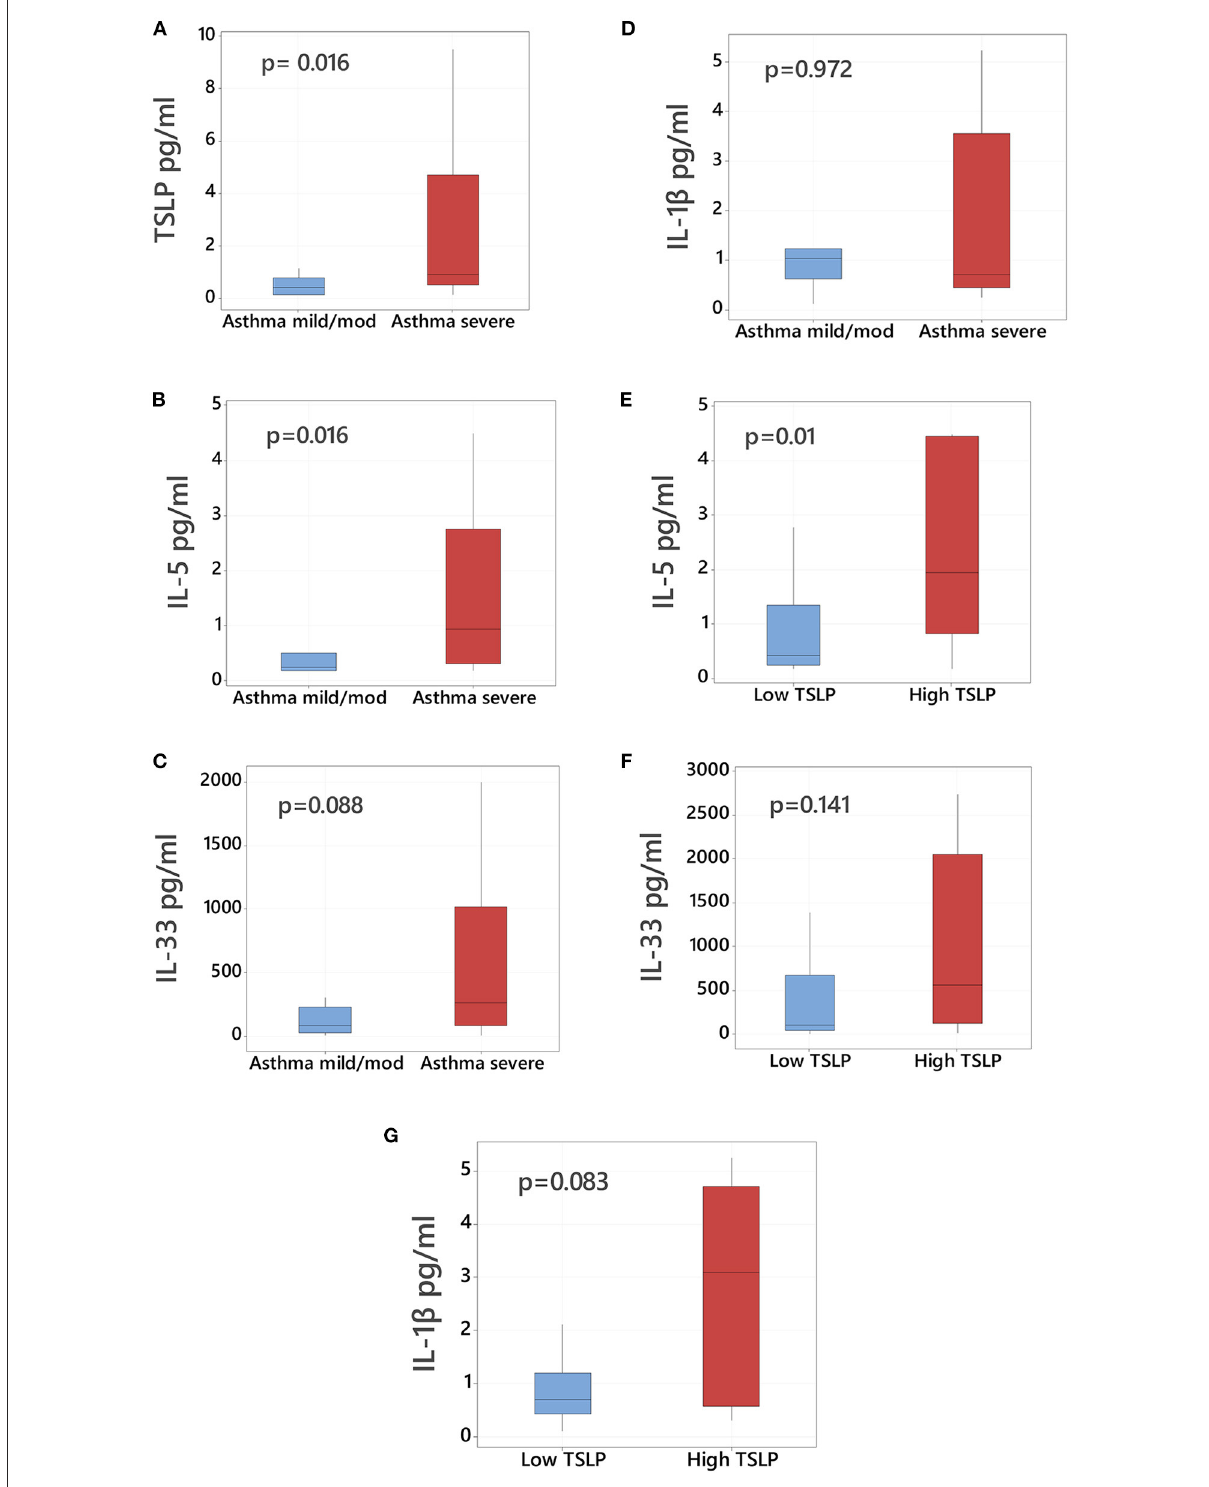
FIGURE1 TSLP bronchoalveolar levels in asthmatic children according to severity. Comparison of bronchoalveolar lavage (BAL) protein levels of (A) TSLP, (B) IL-5, (C) IL-33, and (D) IL-1 β in mild/moderate asthmatic children (left blue boxplot, n = 11) vs. severe asthmatic children (right red boxplot, n = 24). Comparison of BAL levels of (E) IL-5, (F) IL-33, and (G) IL-1 β in asthmatic children with high TSLP ( ≥ 75th percentile) vs. low TSLP ( < 75th percentile) BAL levels. Data presented as boxplots representing 25th − 75th